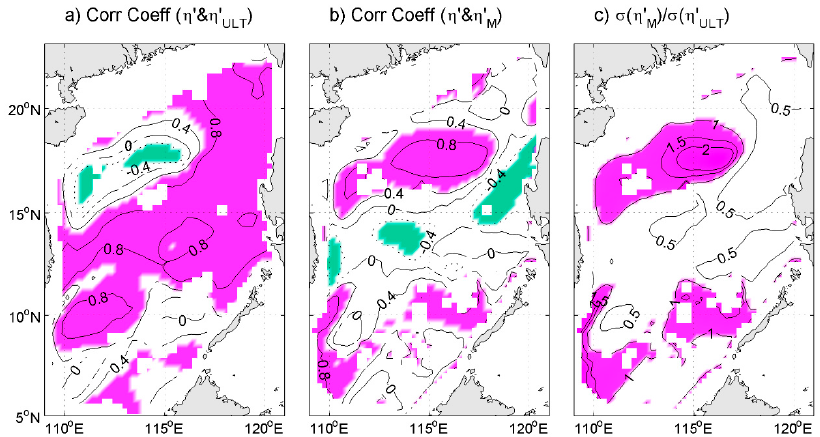
Figure 7. Spatial distributions of correlation coefficient between the monthly η (cid:48) ( a ) with η (cid:48) ULT and ( b ) with η (cid:48) M . Shading in ( a , b ) indicates correlation beyond 95% confidence level; ( c ) The ratio of the standard deviation between M and ULT . The ratio larger than 1 is shaded in ( c ).